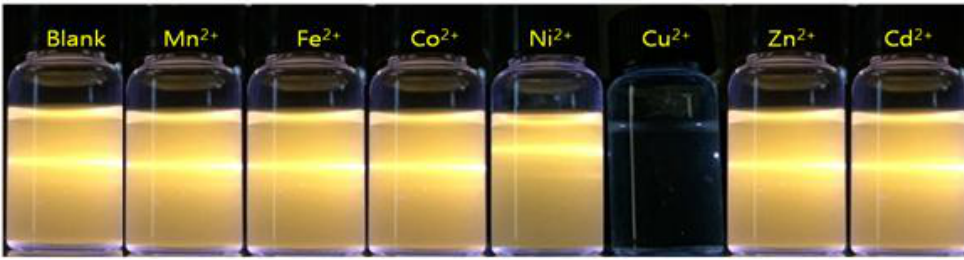
Figure 5. Light scattering image of the ZnS:Mn-Asp NCs upon addition of transition metal ions, taken under irradiation of He-Cd laser (325 nm) light. (‘Blank’ refers to ZnS:Mn-Asp NCs only).